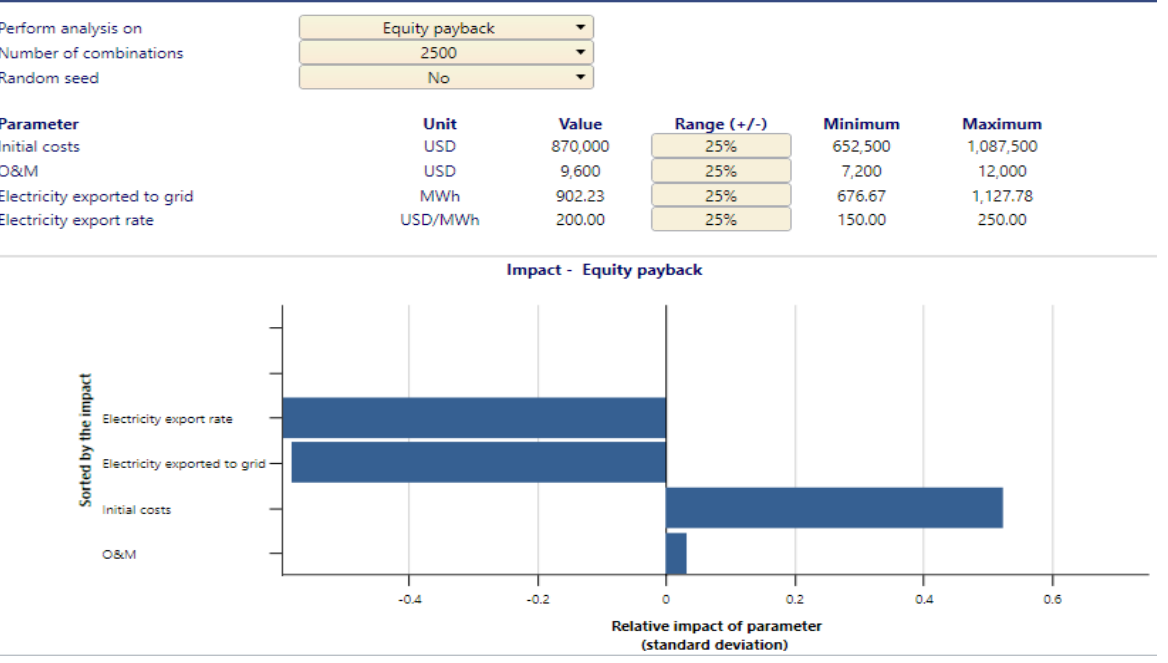
Figure 14. Risks of 650 kW solar–wind RES plant to initial cost and electricity exported to the grid for 0.2 USD/kWh. Table 9. Project fi nancial output parameters for an annual electricity rate of 0.2 USD/kWh.